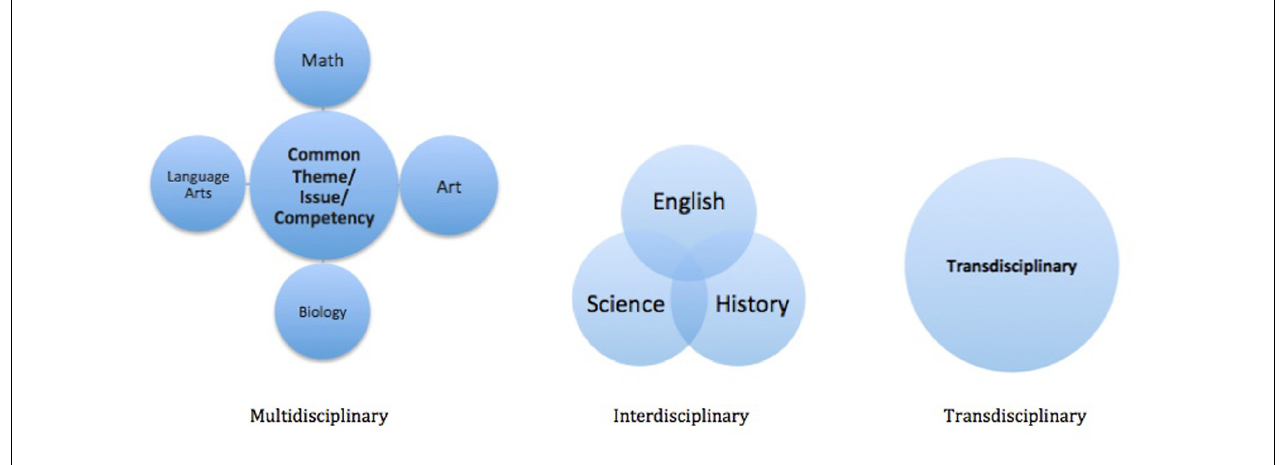
FIGURE 1 | An example of a continuum of